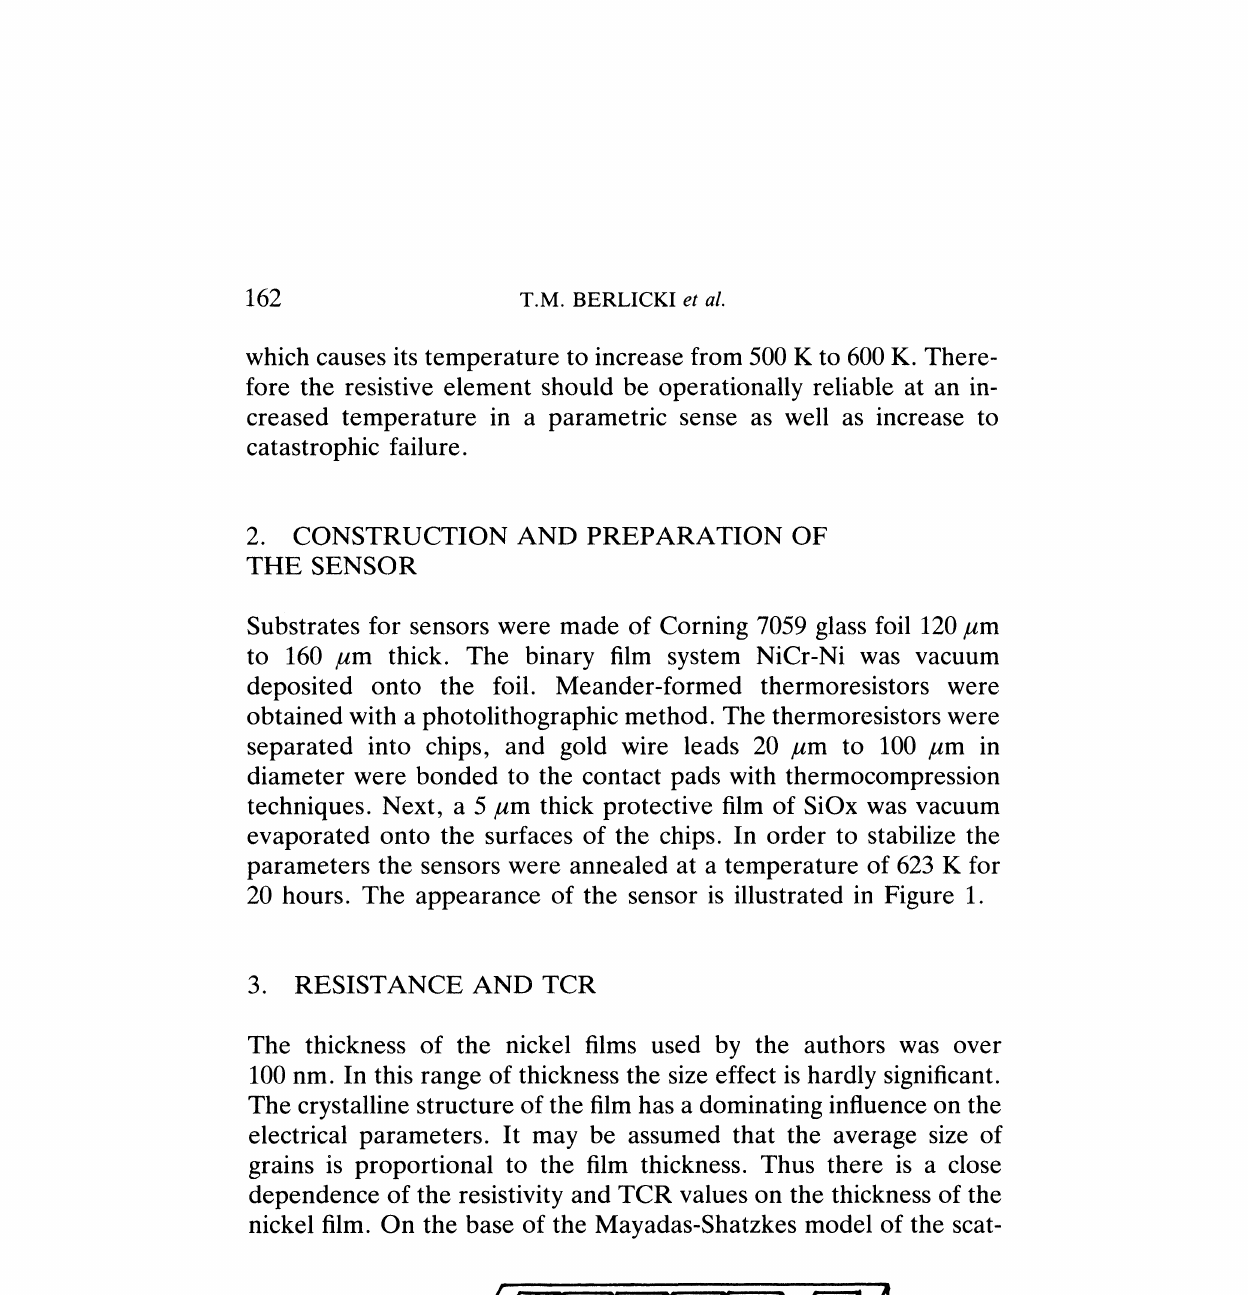
FIGURE Construction of the thermoresistive thin film flow